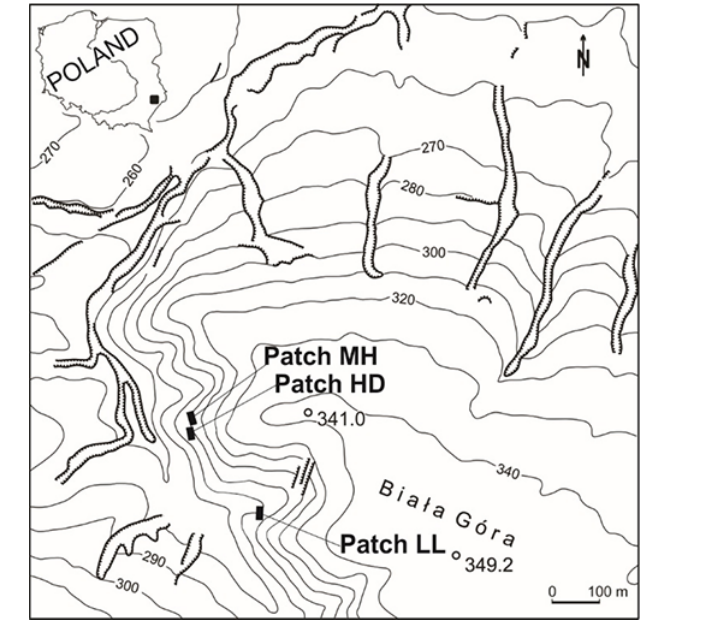
Figure 1 Study area with the location of permanent